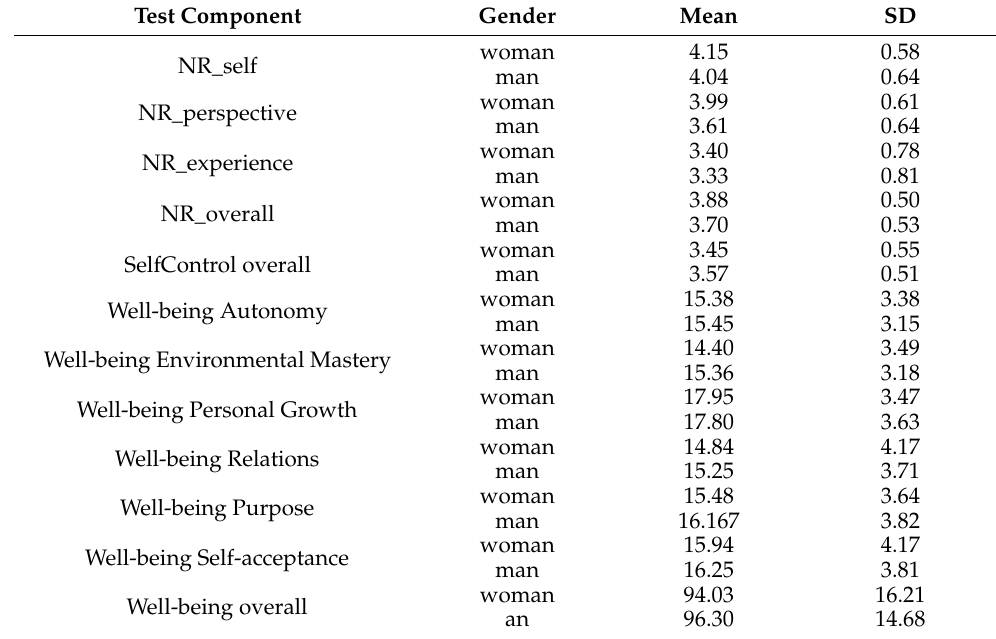
Table 2. The descriptive statistics for particular components of Nature Relatedness Scale and Psychological Well-being .